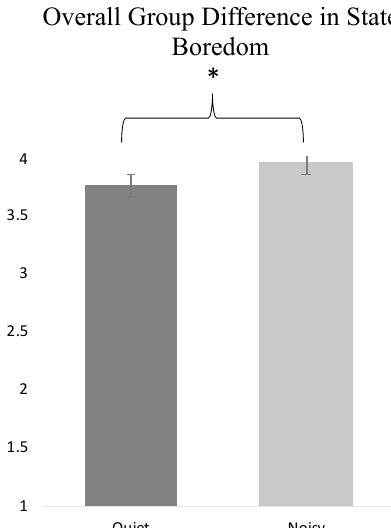
Figure 1 . Difference in Multidimensional State Boredom Scale (MSBS) overall mean score for people in noisier and quieter environments. * p < 0.05. Error bars represent standard error.